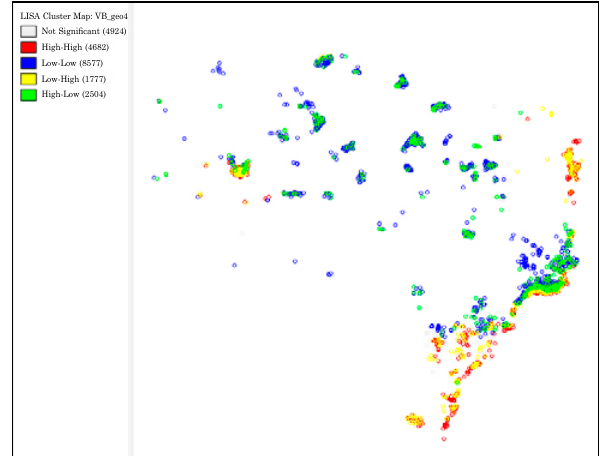
Fig. 2. LISA spatial clusters of house prices in the Vega Baja, Alicante. Weight matrix of contiguity, order